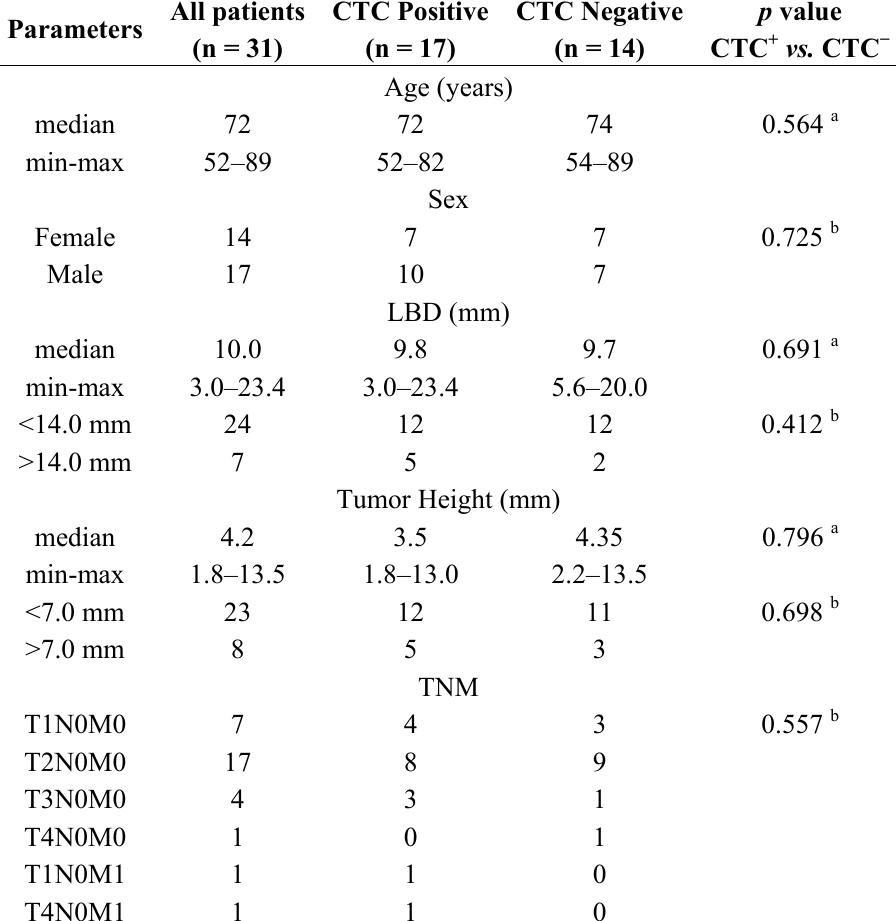
Table 1. Case study characteristics and their association with CTC presence in uveal melanomas. This table reports the number of CTC-positive and CTC-negative cases according to patients’ clinico-pathological prognostic